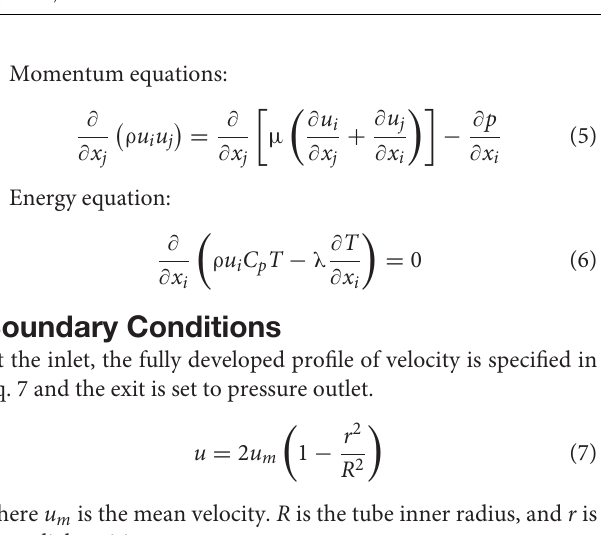
FIGURE 1 | The geometry and cross-section view of the tubes with CCTT. (A) Coaxial cross double twisted tape (CCDTT). (B) Coaxial cross triple twisted tape